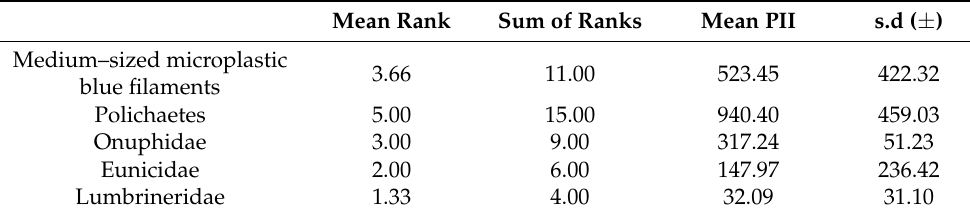
Table 5. Friedman ANOVA results on the breakdown of the contribution by microplastics, total polychaeates and related families to the total variability in Prey Importance Index (PII) between three size classes from a sample of the hollow-snout grenadier from the bathyal plane of the eastern central Tyrrhenian